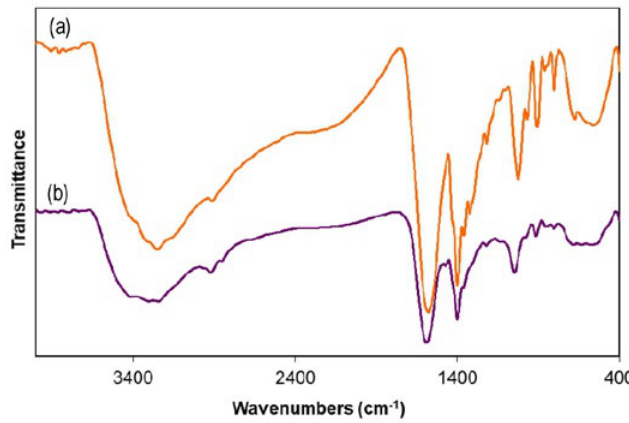
Fig. 5. FT-IR spectra of (a) L- and (b) D-cyst-CdS-QDs.